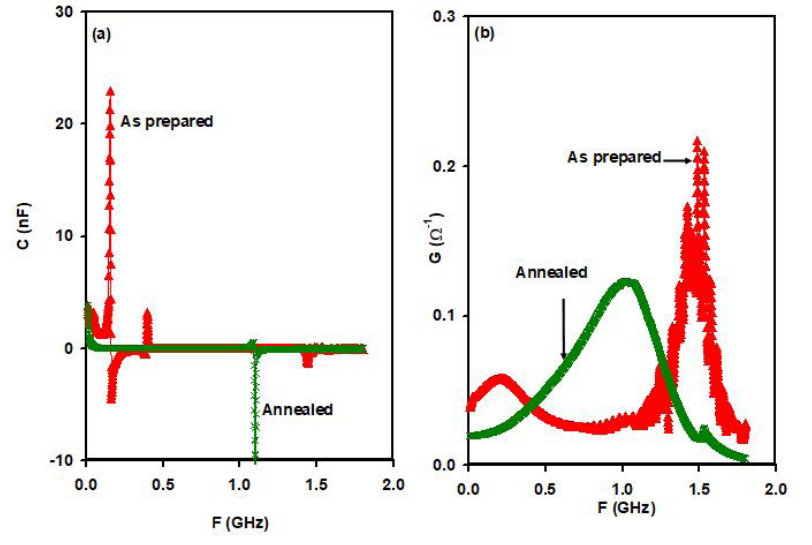
Figure 3. (a) the capacitance and (b) conductance spectra for the Au/CdO/InSe thin film transistors before and after